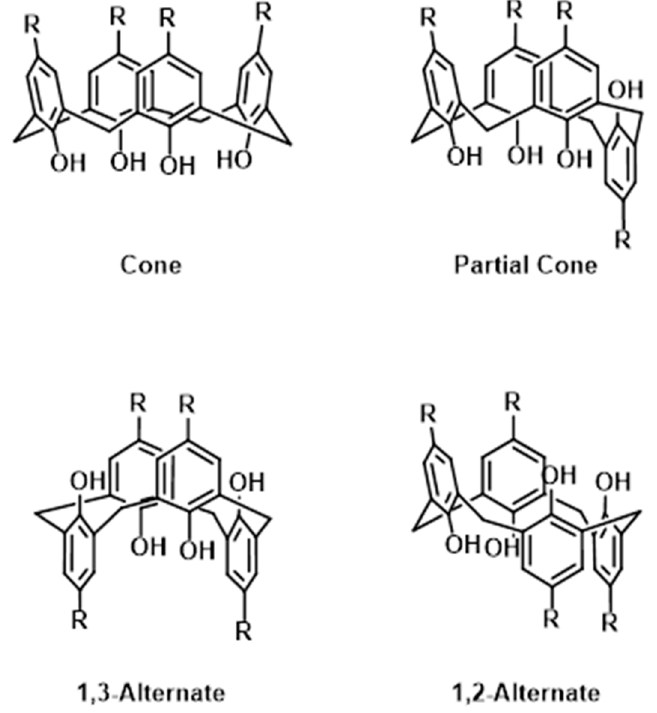
Figure 1. Chemical structures of the four conformations of calix[4]arene.